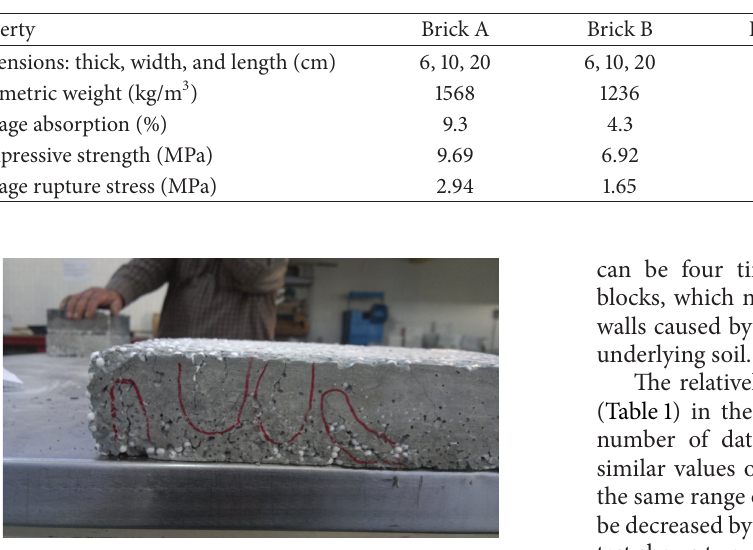
Figure 1: Resulting cracks in the brick under Compression test.